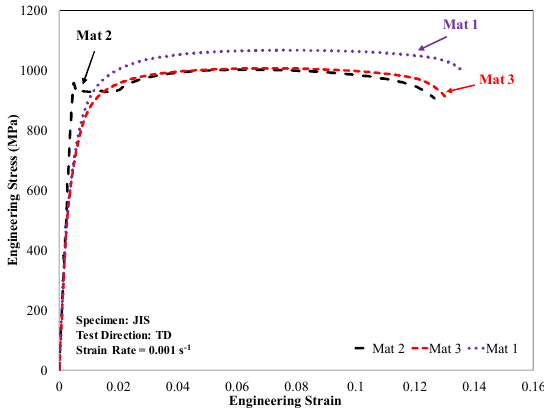
Fig. 5. Average curves for the 0.001 s -1 results of each material.